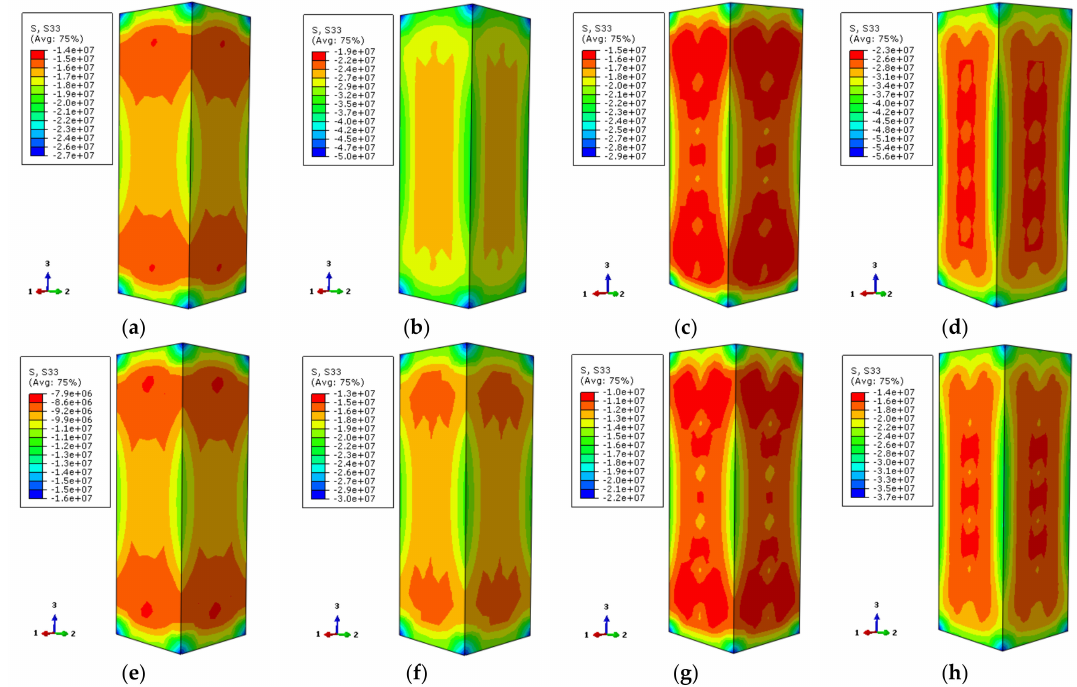
Figure 16. The vertical stress distribution of concrete ( a ) DS-200-0-0.75; ( b ) DS-200-0-1; ( c )